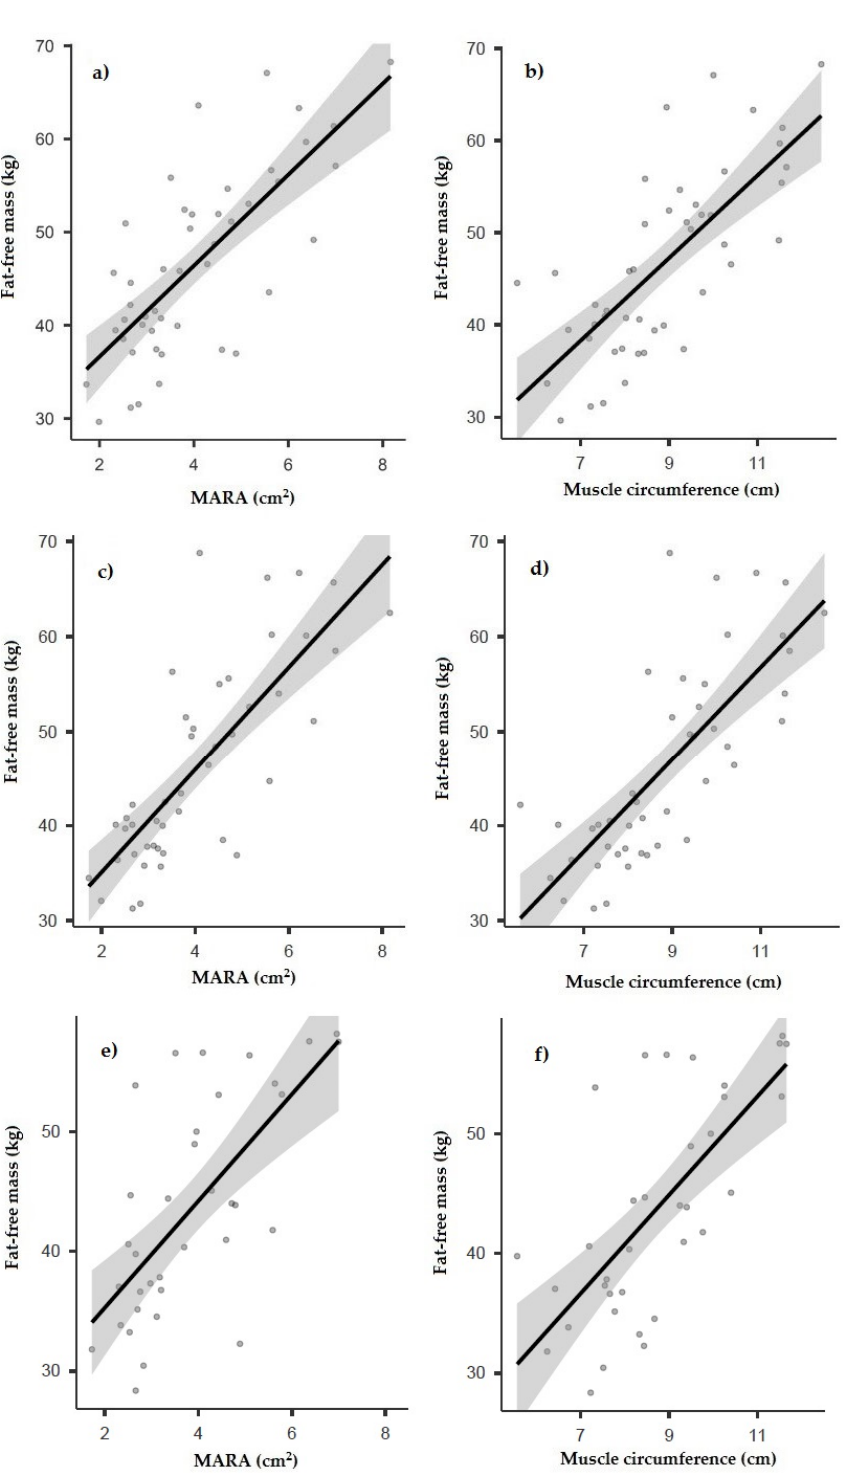
Figure 1. Correlation between MARA and muscle circumference and fat-free mass determined by BIA ( a , b ), anthropometry ( c , d ), and DXA ( e , f ). MARA: muscular area rectus anterior.